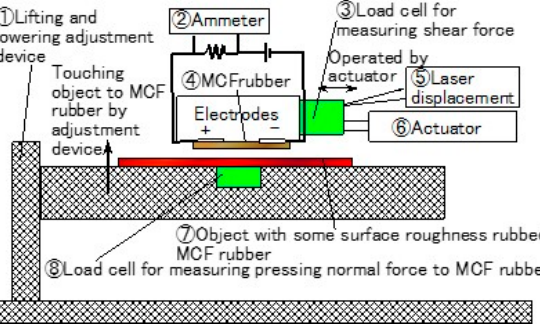
Figure A1. Schematic of the experimental apparatus used to investigate the electric characteristics in the NFE [20].